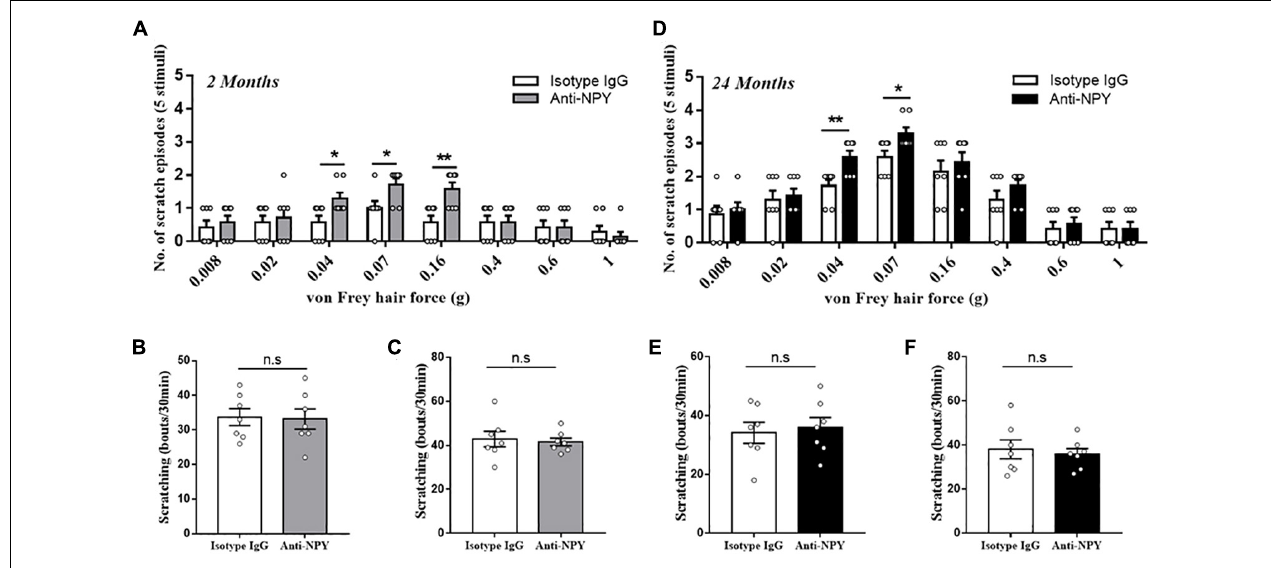
FIGURE 3 | Neutralizing NPY induced mechanical itch. (A) Alloknesis scores in young mice receiving an intrathecal injection of isotype IgG ( n = 7, 4 male and 3 female) and anti-NPY IgG ( n = 7, 4 male and 3 female) mice. * P < 0.05, ** P < 0.01, isotype IgG versus anti-NPY IgG, Student’s t -test. (B) Scratching responses to intradermal injections of histamine in young mice receiving an intrathecal injection of isotype IgG ( n = 7, 4 male and 3 female) and anti-NPY IgG ( n = 7, 4 male and 3 female) mice. n.s, not significant, Student’s t -test. (C) Scratching responses to intradermal injections of chloroquine in young mice receiving an intrathecal injection of isotype IgG ( n = 7, 4 male and 3 female) and anti-NPY IgG ( n = 7, 4 male and 3 female) mice. n.s, not significant, Student’s t -test. (D) Alloknesis scores in aged mice receiving an intrathecal injection of isotype IgG ( n = 7, 4 male and 3 female) and anti-NPY IgG ( n = 7, 4 male and 3 female) mice. * P < 0.05, ** P < 0.01, isotype IgG versus anti-NPY IgG, Student’s t -test. (E) Scratching responses to intradermal injections of histamine in aged mice receiving an intrathecal injection of isotype IgG ( n = 7, 4 male and 3 female) and anti-NPY IgG ( n = 7, 4 male and 3 female) mice. n.s, not significant, Student’s t -test. (F) Scratching responses to intradermal injections of chloroquine in aged mice receiving an intrathecal injection of isotype IgG ( n = 7, 4 male and 3 female) and anti-NPY IgG ( n = 7, 4 male and 3 female) mice. n.s, not significant, Student’s t